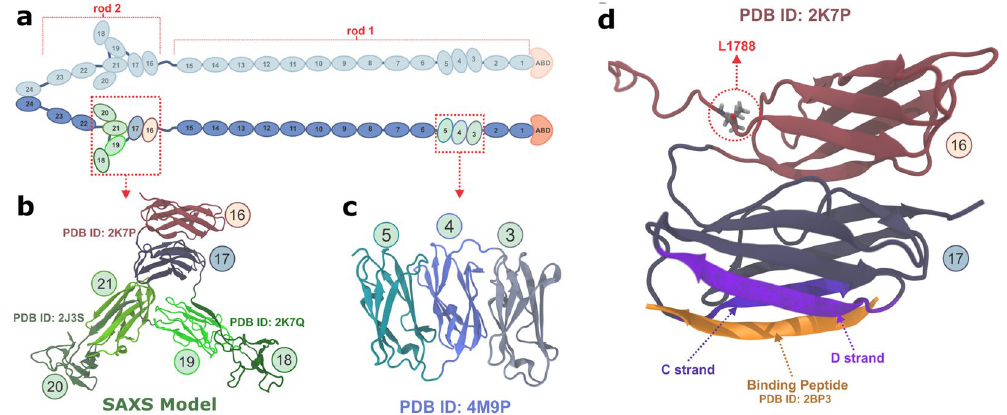
Figure 1. Schematic representation of Filamin. ( a ) Schematic representation of FLN dimer having 24 Ig- domains (blue) and the actin-binding domain (ABD, orange) in monomer. The two monomers are dimerized via domains 24. The atomic detailed structures of Ig-domains that form compact structures by interacting with the neighboring domains are highlighted and shown in green, and the domains 16 and 17 studied here are shown in light red and light blue, respectively. The structures of compact domain fragments are shown in panel (b) (FLNa16-21 21 ) and in panel (c) (FLNa3-5 20 ). The FLNa16-21 model 21 shown in ( b ) is obtained from SAXS using the high resolution structures of FLNa16-17 22 , FLNa18-19 22 , and FLNa20-21 23 . ( d ) Shows the structure of the domain pair FLNa16-17 22 studied here. The binding mode of GPIb α -peptide (orange) to groove between the strands C and D of FLNa17 is shown. The FLNa16-17 - GPIb α -peptide structure is obtained by superimposing FLNa17-GPIb α -peptide X-ray structure 26 with FLNa16-17 structure 22 . L1788, whose mutation to arginine causes FMD 29 is shown as